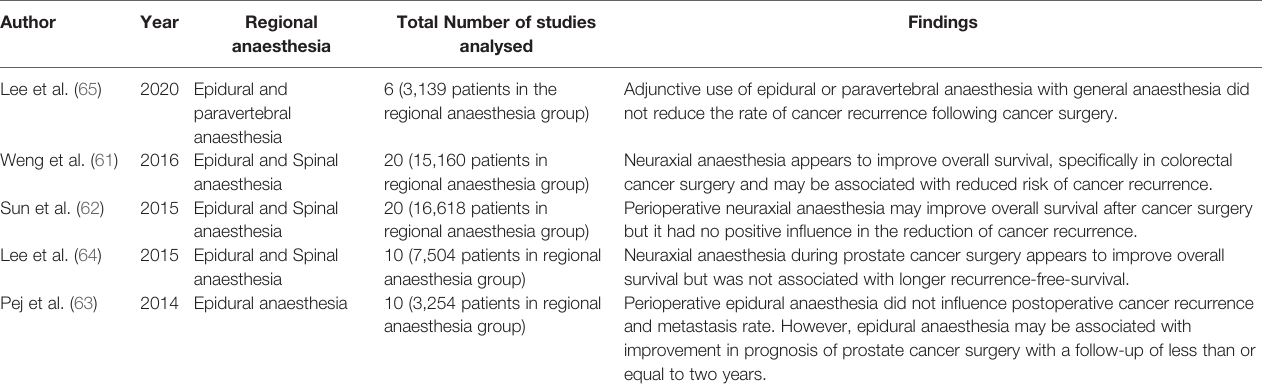
TABLE 2 | Summary of recent meta-analysis of neuraxial anaesthesia and cancer